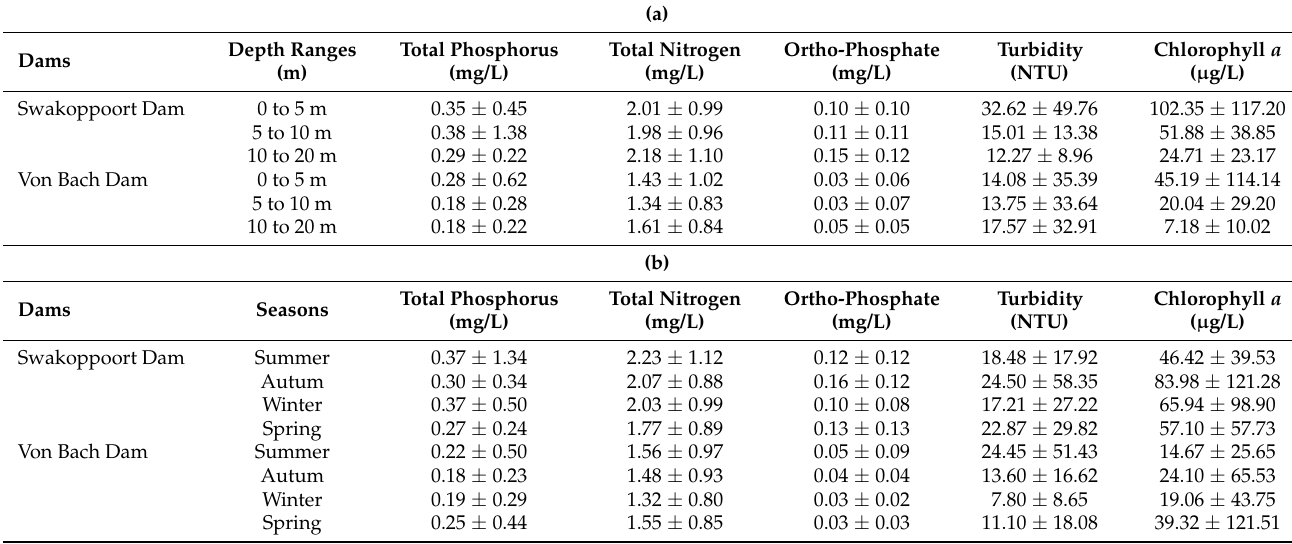
Table 3. The average ± standard deviation of the physiochemical characteristics of the Swakoppoort and Von Bach dams at (a) the different depth ranges; and (b) among seasons.